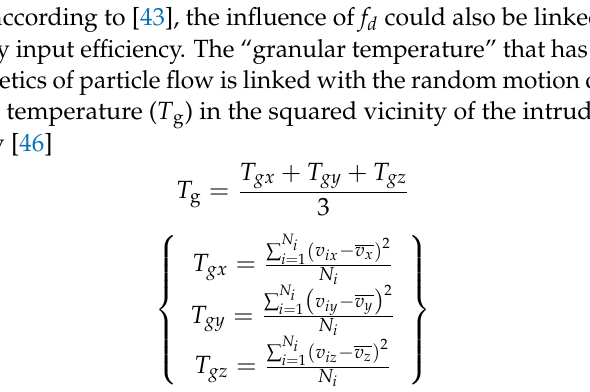
Figure 9. The influence of f on: ( a ) porosity of bed layer at 20· d s height; ( b ) the granular temperature.